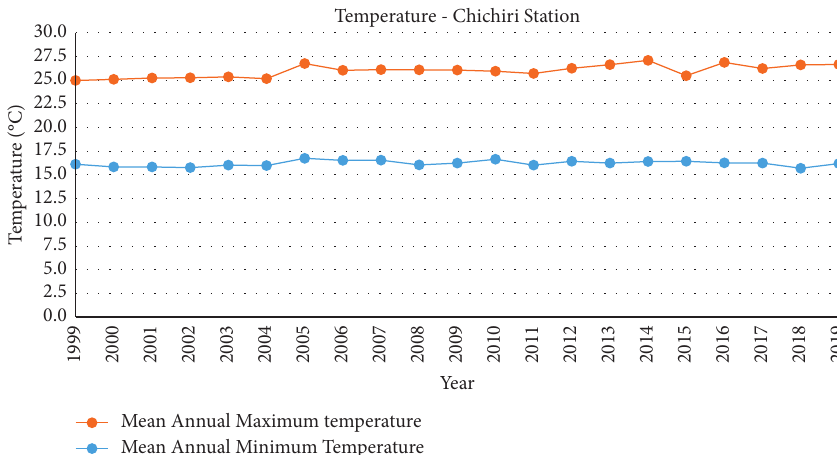
Figure 5: Maximum and minimum mean annual temperature (source: Malawi Department of Climate Change and Meteorological